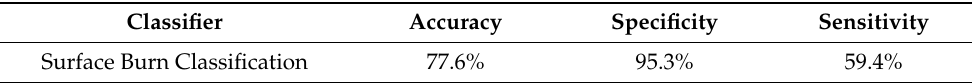
Table 3. Support Vector Machine Surface Burn Classification Results.